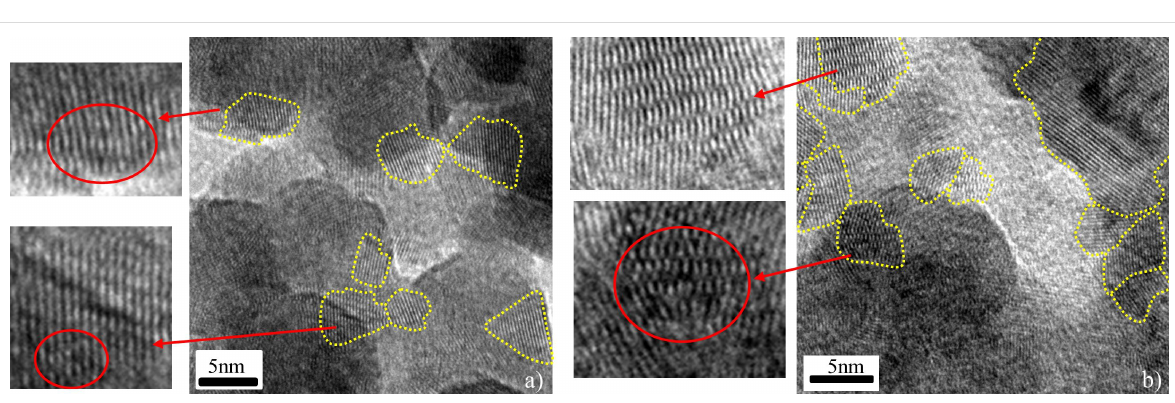
Figure 7: HRTEM characterization of Hf NTFs formed with energetic Hf NPs deposition and substrate bias: a) V s = 2 kV and b) V s = 4.5 kV. In both cases, the films are composed of nanosized crystal grains (yellow regions). A higher magnification of crystal grains shows distorted areas of their crystal